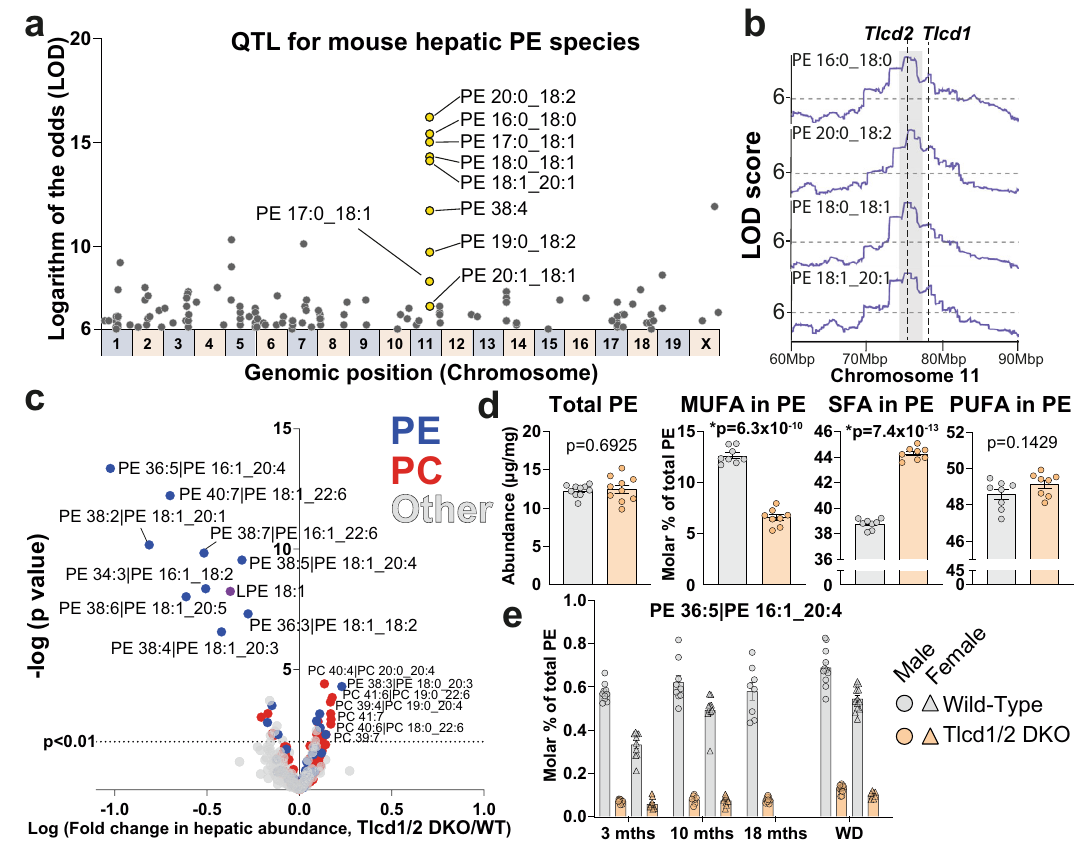
Fig. 1 | Tlcd1 and Tlcd2 genes regulate the levels of SFA- and MUFA-containing PE species in mouse liver. a Quantitative trait loci for all PE species measured by LC – MS/MSinthetotalliverof8differentfounderstrains( n =8mice/strain)and 384 diversity outbred mice, then mapped onto the mouse genome. This reveals the genomic position and founder strain allele effect pattern for each PE species (data from Linke et al. 14 ) b LOD score plots for selected hepatic PE species across the indicated region in mouse chromosome 11 (graphs adapted from lipidgenie.com). The position of Tlcd1/2 genes is indicated with dotted lines. c Volcano plot of lipid speciesmeasuredwithhighcon fi dence(490speciesintotal,PCindicatedinredand PE in blue) in wild-type and Tlcd1/2 DKO chow-fed, 3-month-old male mouse livers ( n =10 mice/group). d Total measured PE levels and molar percentage of MUFA and